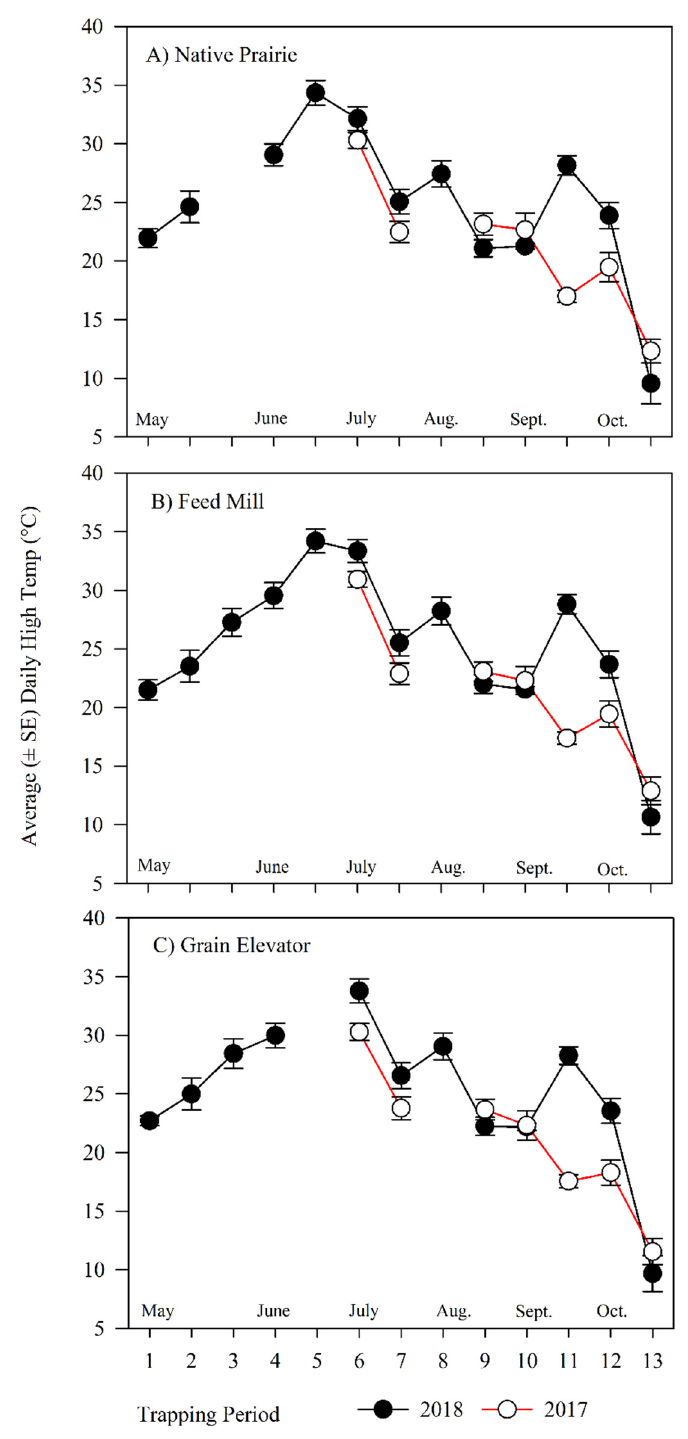
Figure 4. Mean (±SE) daily temperature (°C) for each Lindgren trapping study for ( A ) native prairie, ( B ) feed mill, and ( C ) grain elevator. Red lines and white circles are for 2017 and black lines and black circles are for 2018. If the temperature data file was corrupted, the data was not included in the temperature graphs.